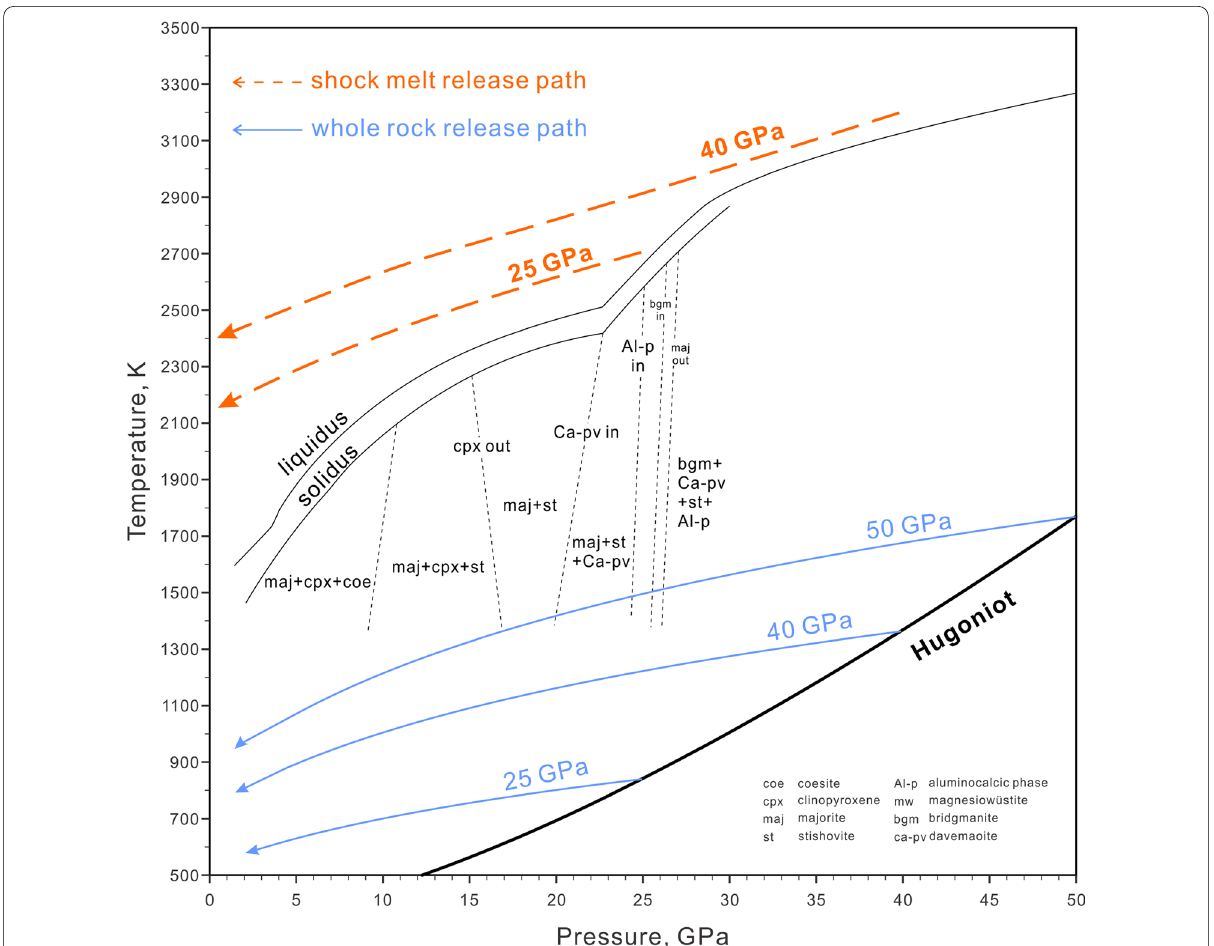
Fig. 6 The adiabatic release path of bulk basalt (light purple) and basaltic melt (orange) superimposed on a phase diagram based on MORB from Fei and Bertka (1999) and Hirose et al. (1999). The P–T Hugoniot is the same as Fig. 3. Parameters used for the calculations are listed in Table 1 and 2